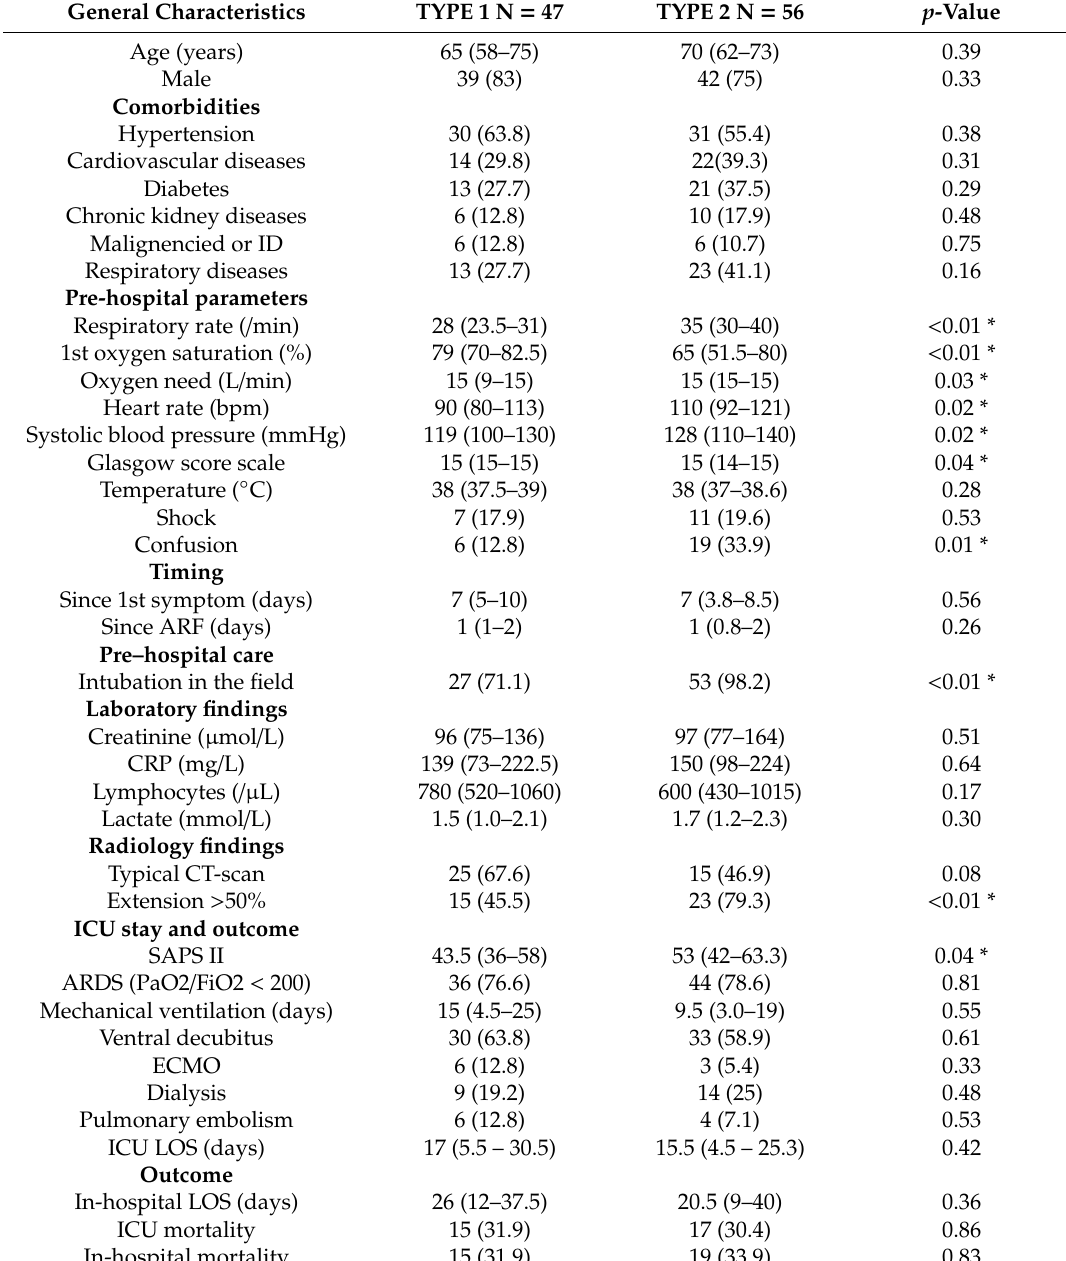
Table 2. Characteristics of the study population and comparison between Type 1 and Type 2 clinical